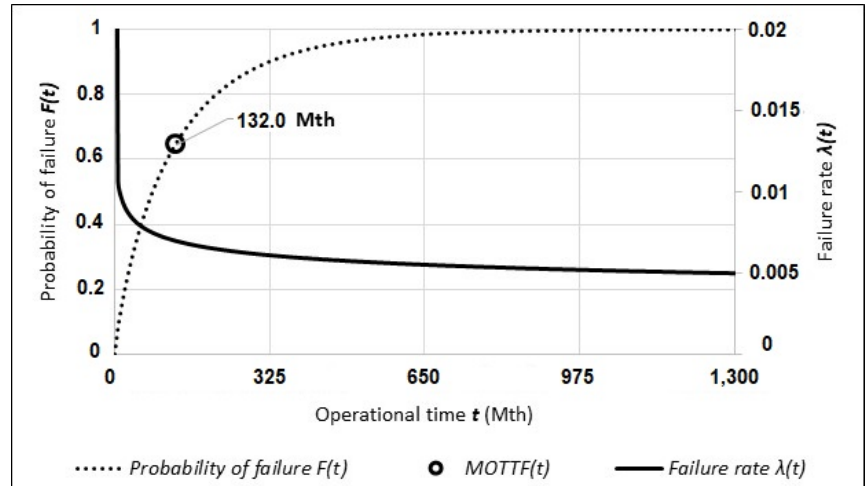
Figure 4 Failure rate λ (t) for the forwarder f810D-002.